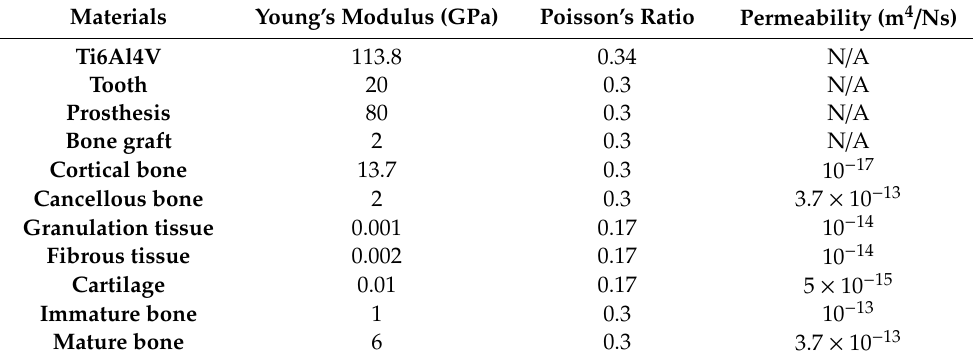
Figure 2. FEM model of ( a ) bone-tooth and ( b ) bone-implant-prosthesis systems. Table 1. The material properties used in the current work [29].